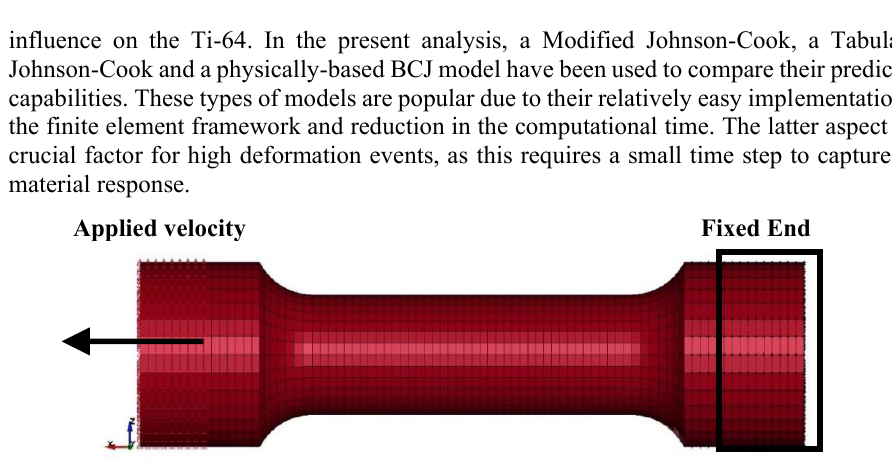
Fig. 4. Three-dimensional cylindrical numerical model with LSDYNA-Explicit ®